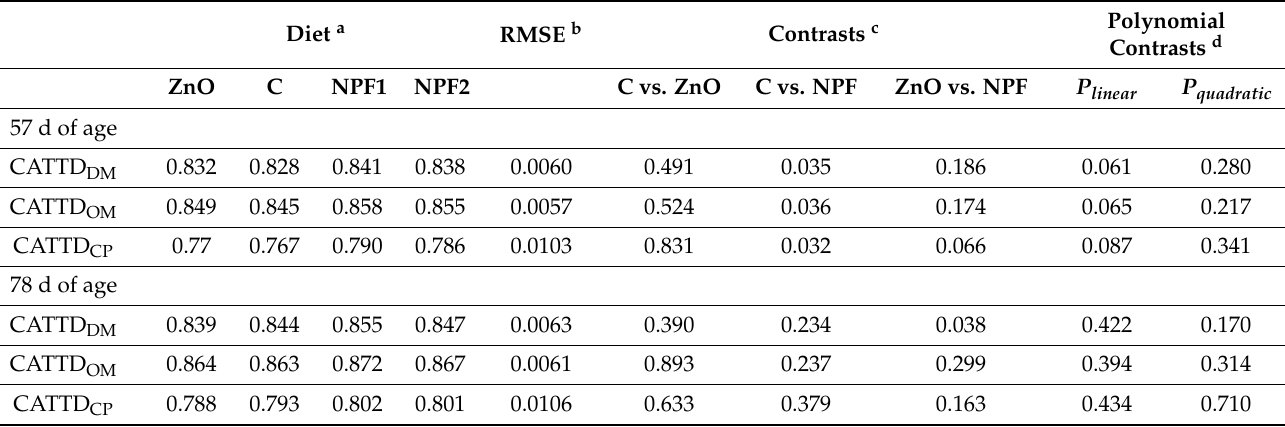
Polynomial Contrasts d